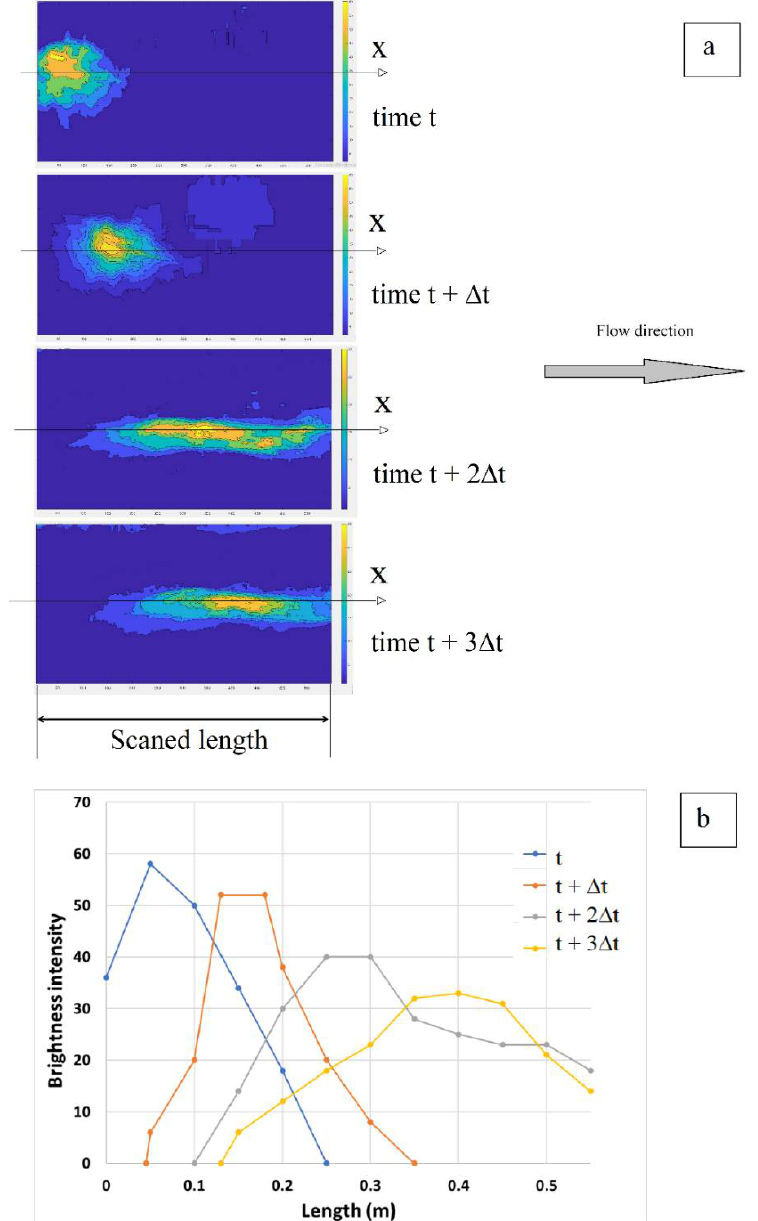
Figure 9. Quinine tracer movement over the scanned area for one run over the plane surface (Q = 113.63 mL/s, V tr = 10 mL): ( a ) Brightness intensity contour plots and ( b ) Brightness intensity along the flume’s length x (scanned area), in time (t, t + Δt, t + 2Δt, t + 3Δt).